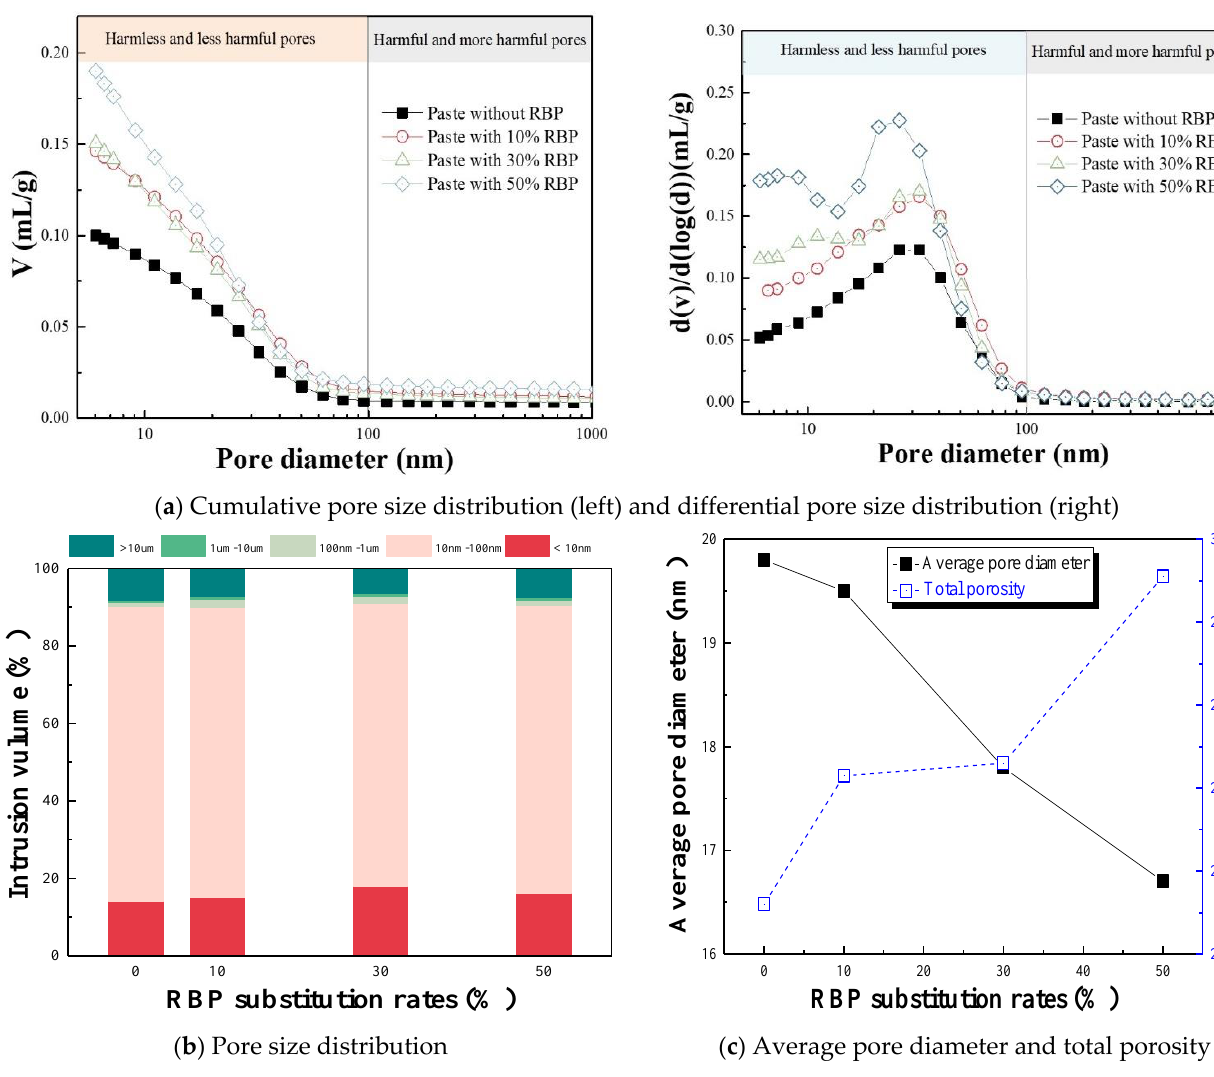
Figure 5. Pore size distribution of cementitious materials with various RBP contents.